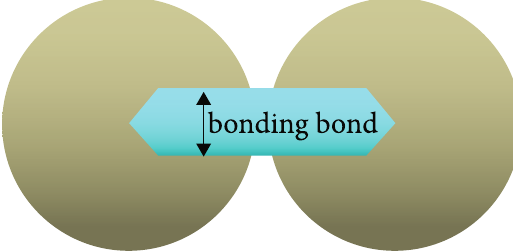
Figure 1: The basic unit of the whole aluminum honeycomb material is spherical particles, and the bonding bond connects the two spherical